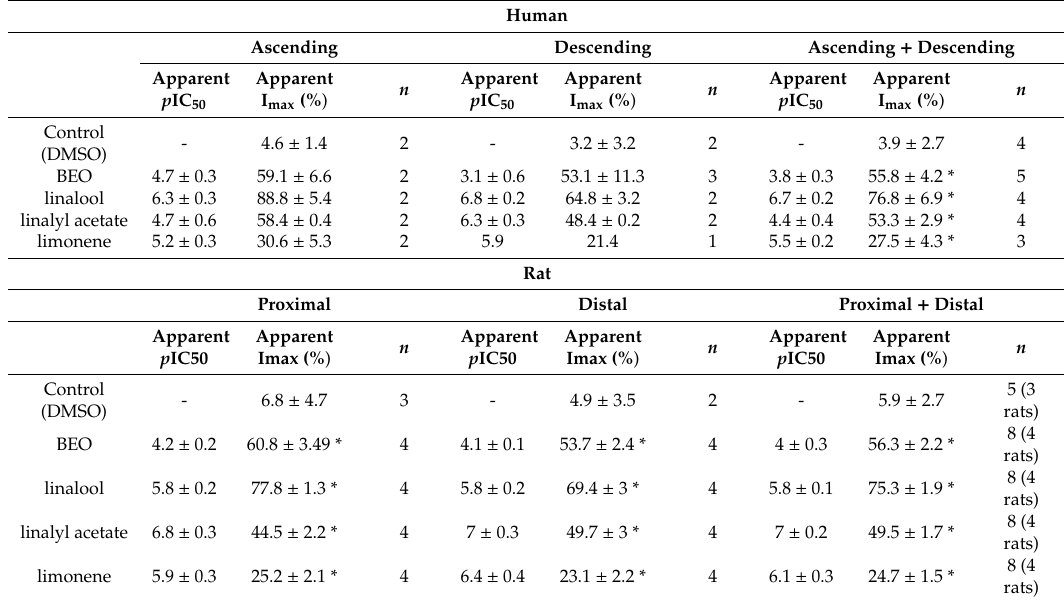
Table 1. Apparent p IC 50 and apparent I max for the inhibition of EFS-evoked contractions in human and rat colon. Human Ascending Descending Ascending + Descending